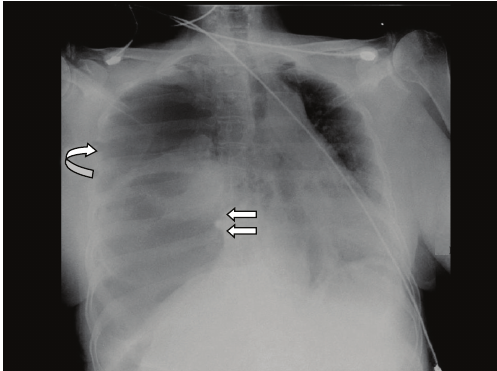
Figure 1: Bedside chest radiograph showed a right upper lucency (curved arrow) with left mediastinal shift in relationship with tension pneumothorax.The air present in the lower part of the right hemithoraxwas retrospectively interpreted as caecal distension with perforation.